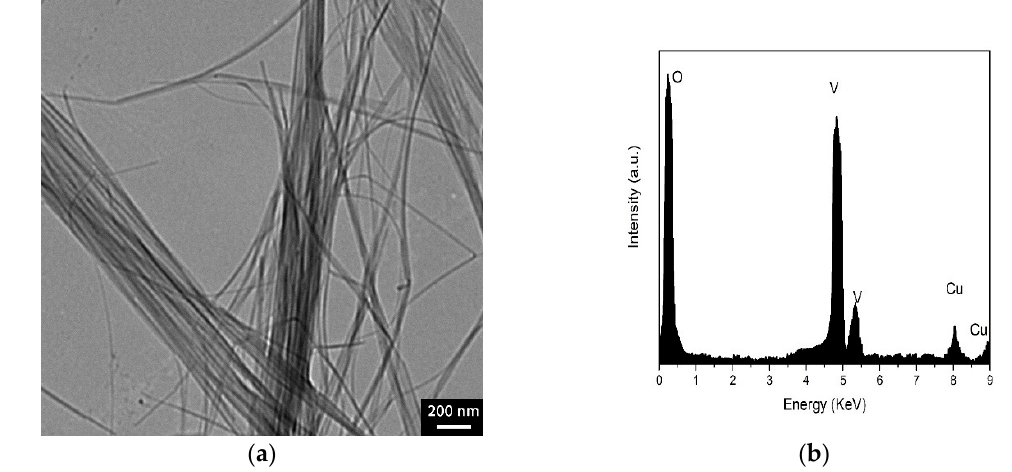
Figure 3. TEM image ( a ) and selected area EDX analysis ( b ) of V 2 O 5 nanofiber cluster.